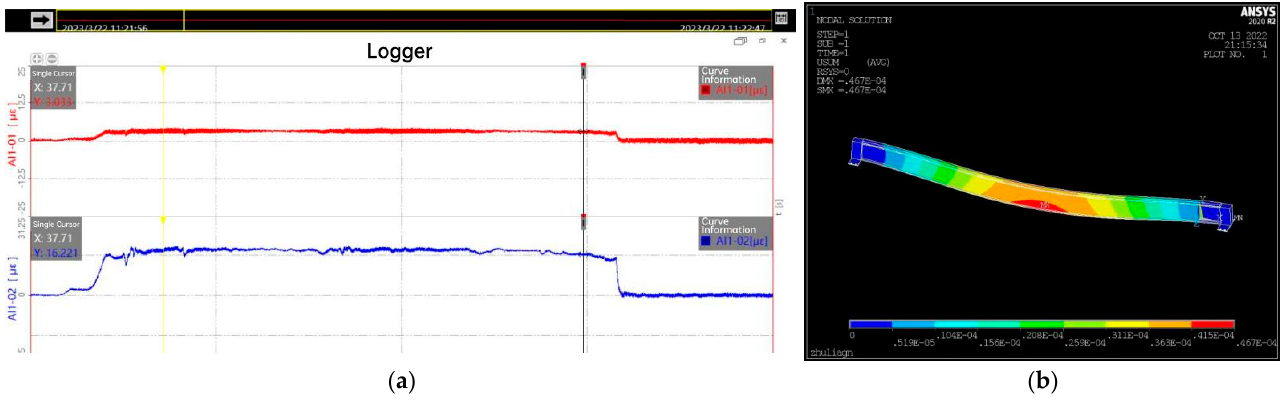
Figure 13. The stress analysis of the main beam. ( a ) The results of stress-time curve analysis. ( b ) The results of finite-element analysis.